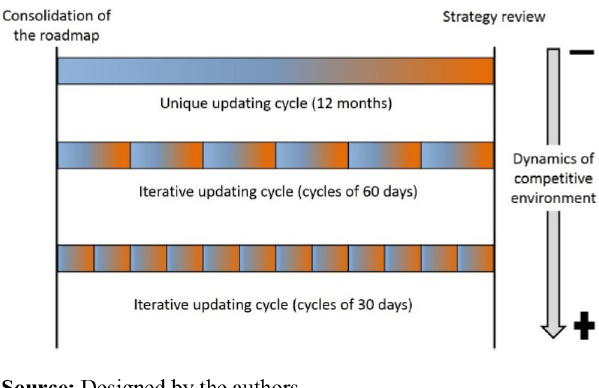
Figure 4. Planning